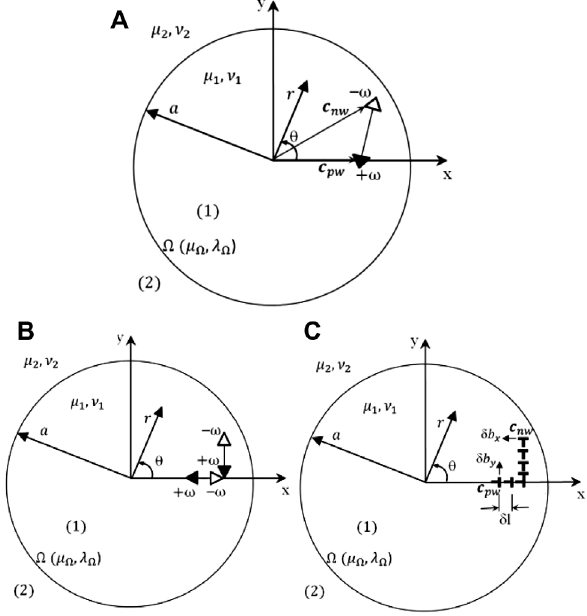
Figure 1 (A) A two-axes dipole of wedge disclinations with arbitrary orientation of its arm in a nanowire embedded in an infinite matrix. (B) The equivalent configuration of two disclination dipoles with orthogonal arms. (C) Finite walls of infinitesimal edge dislocations modeling the two disclination